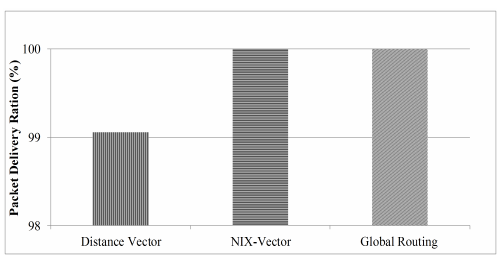
Figure 9: Packet Delivery Ratio